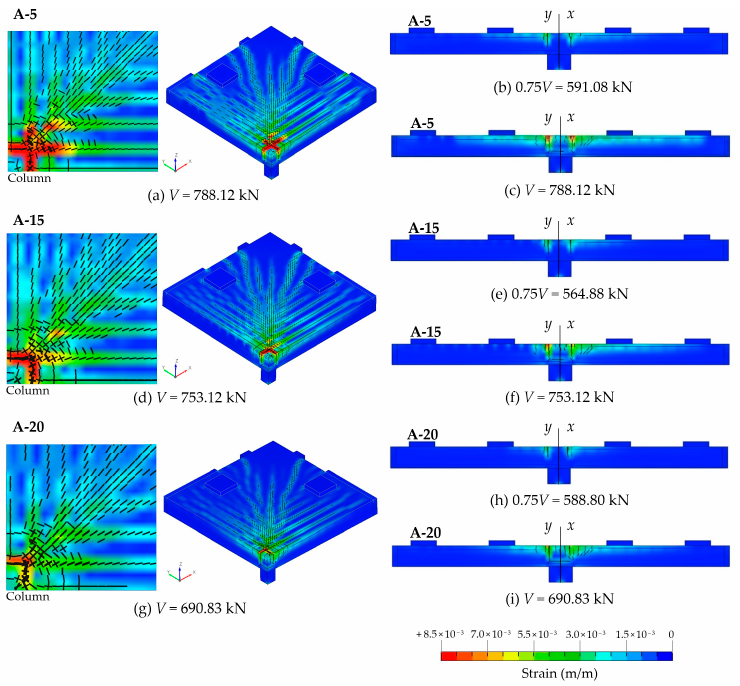
Figure 15. Cracking pattern of Series A models.